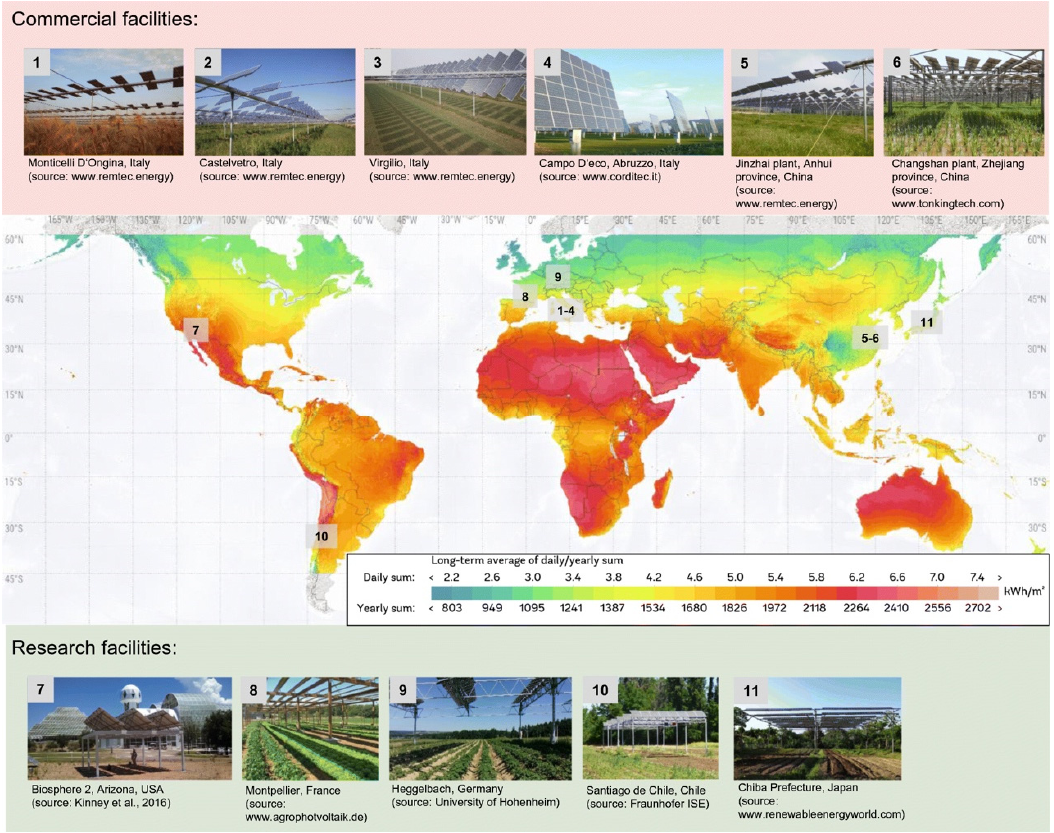
Figure 1. Typical agrivoltaic research facilities worldwide. [15].